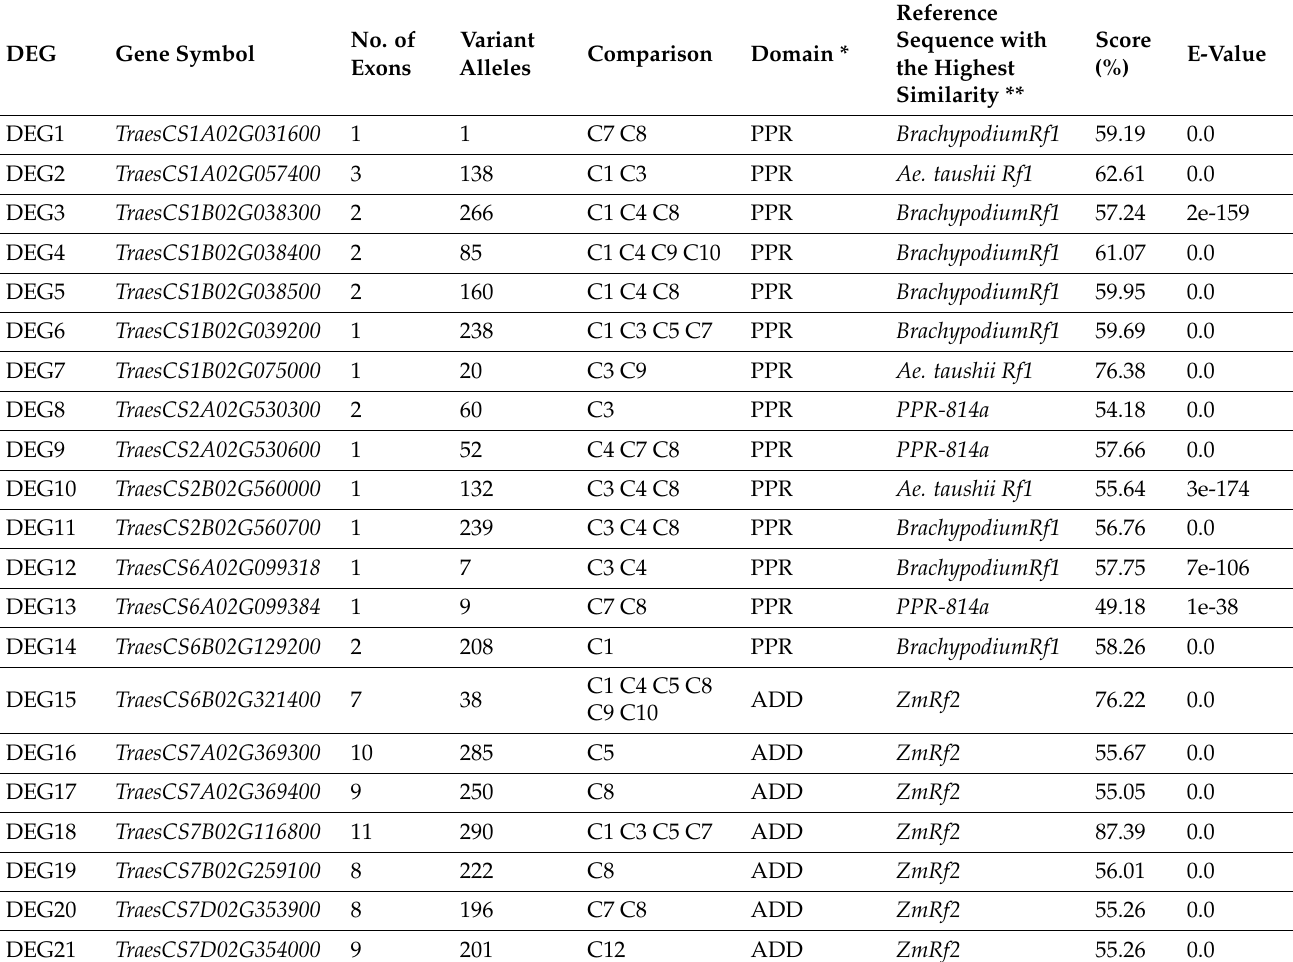
Table 2. Characteristics of 21 DEGs selected by a targeted RNA-seq analysis using the Ensembl Plants database.